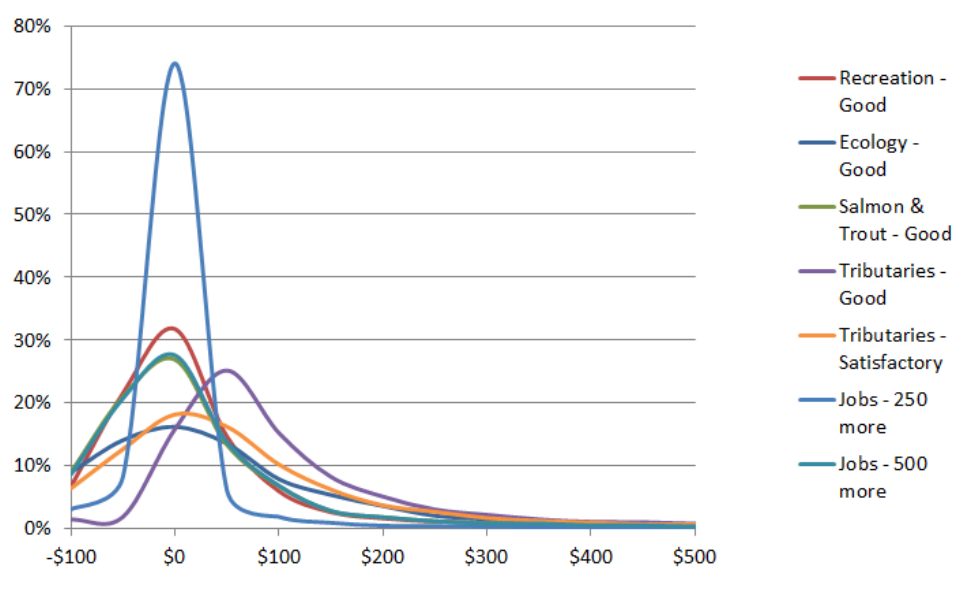
Figure 3. Distribution of WTP for Improvements (Model 5).